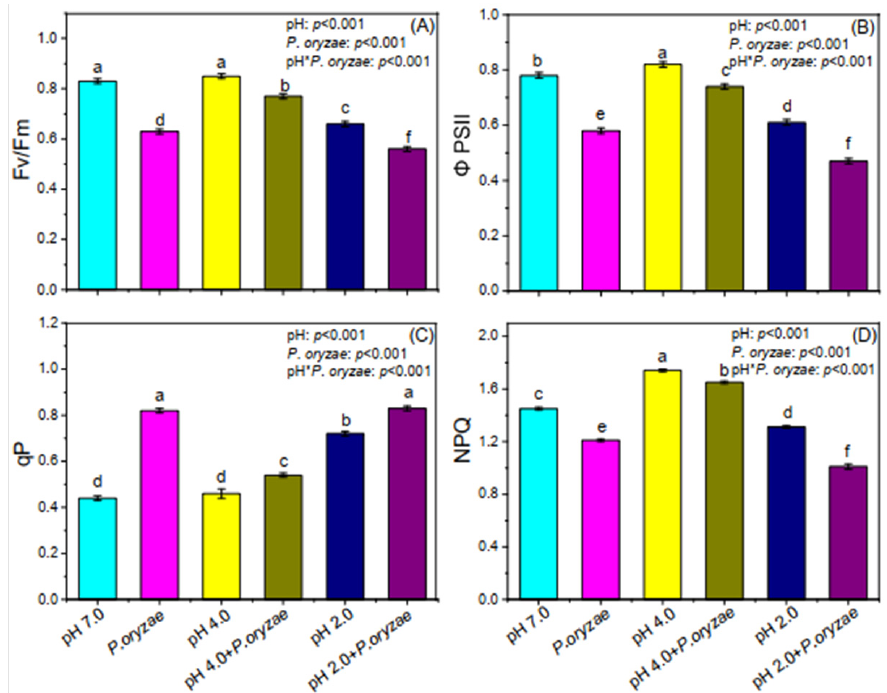
Figure 3. Effects of SAR and P. oryza on the maximum quantum yield (Fv/Fm, A ), potential activity of PSII ( Φ PSII, B ), photochemical quenching (qP, C ), and non-photochemical quenching of fluorescence (NPQ, D ) in rice seedlings. Significant differences at p < 0.05 are shown with different lowercase letters. Values are the average ± standard error ( n = 9).